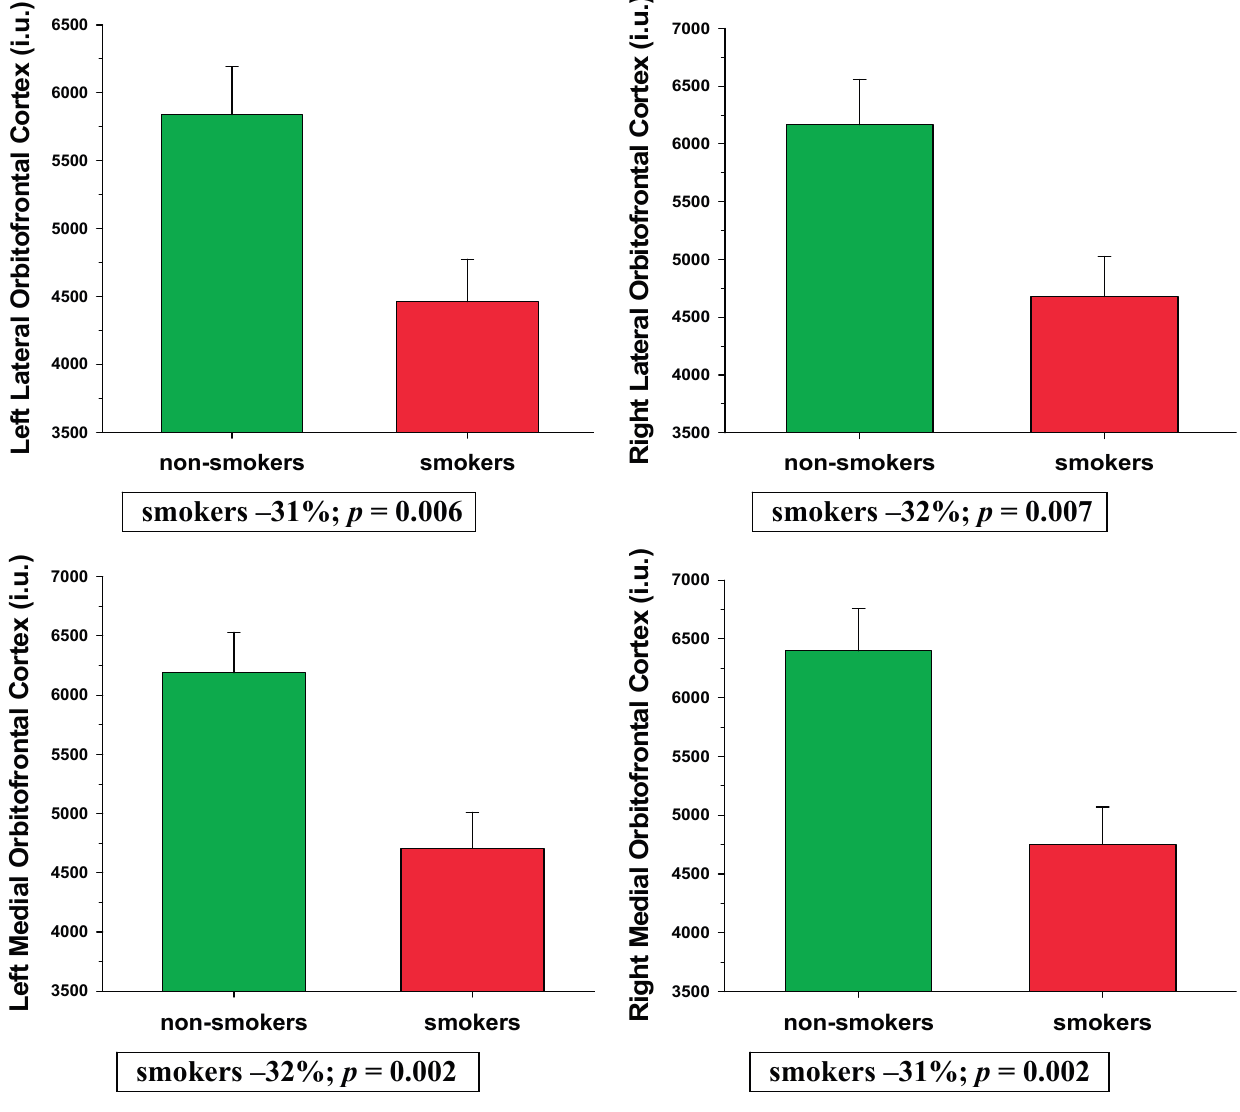
Figure 1. Comparisons of smokers and non-smokers on BREOS perfusion